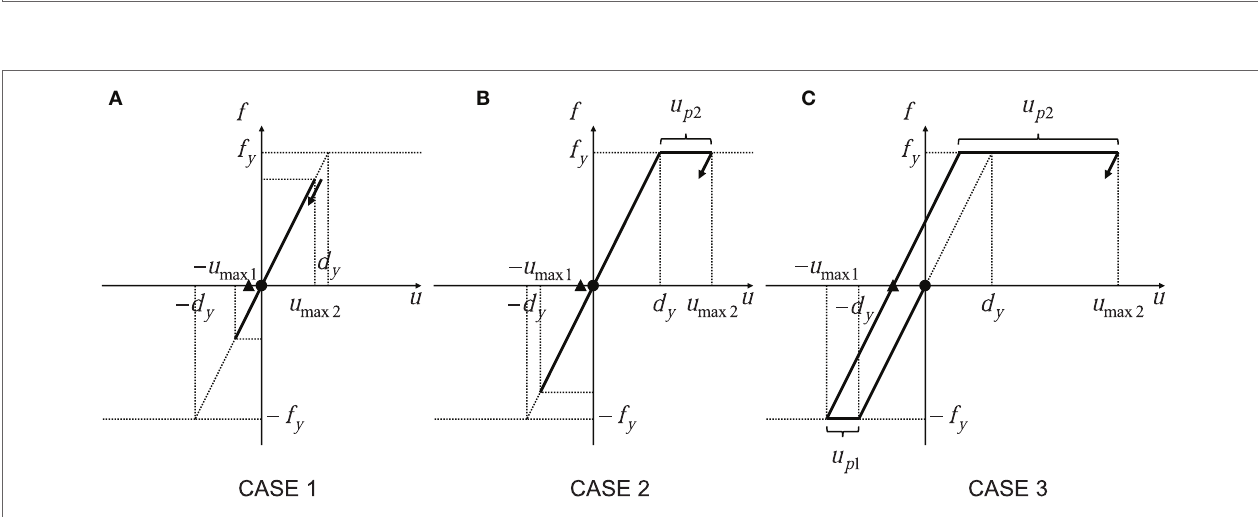
FigUre 3 | Prediction of maximum elastic–plastic deformation under double impulse based on energy approach: (a) case 1: elastic response; (B) case 2: plastic response after the second impulse; and (c) case 3: plastic response after the first impulse ( • : first impulse,  : second impulse).